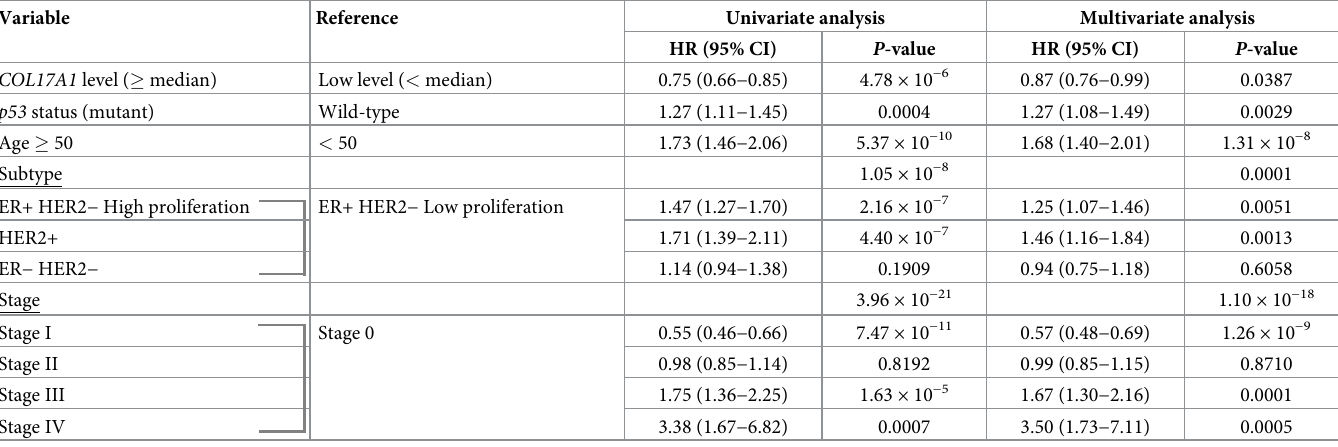
Table 1. Univariate and multivariate Cox regression model using METABRIC